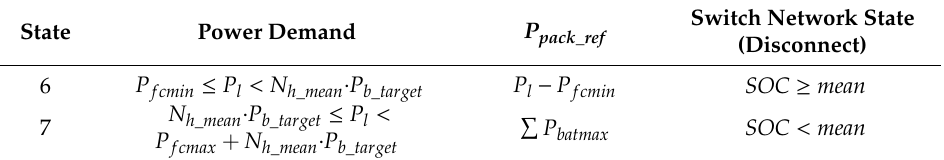
Table 5. Rules of EEMS ( N high < N low